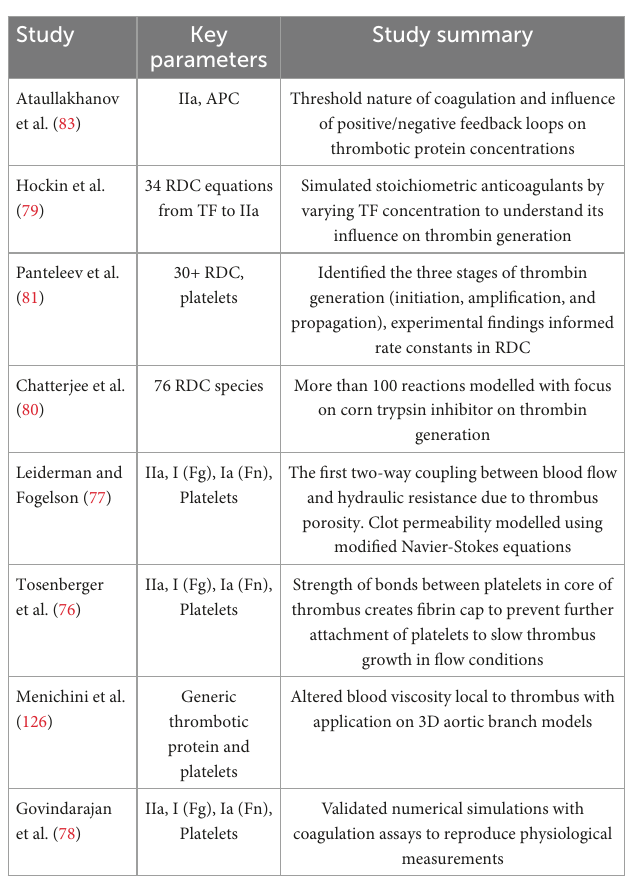
TABLE 2 Mathematical models of